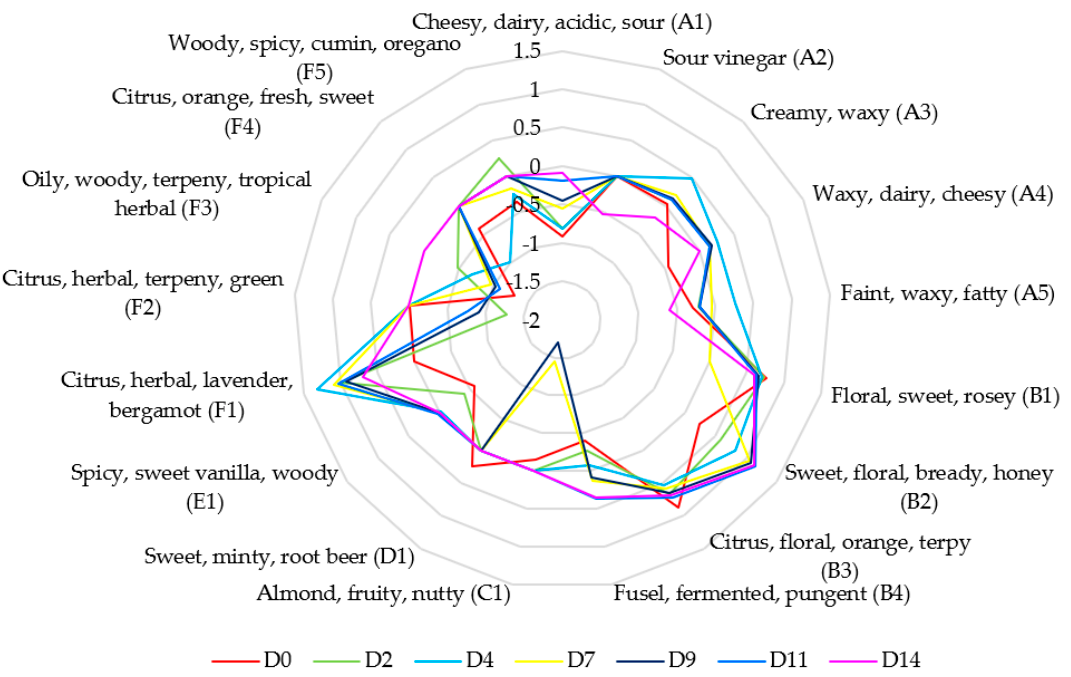
Figure 6. Estimated sensory pro fi le is expressed as the log of the OAV for most representative vola- tile organic compounds (%area > 1%) with kombucha fermentation time (day) at 30 °C (OAV = con- centration/ perception threshold).